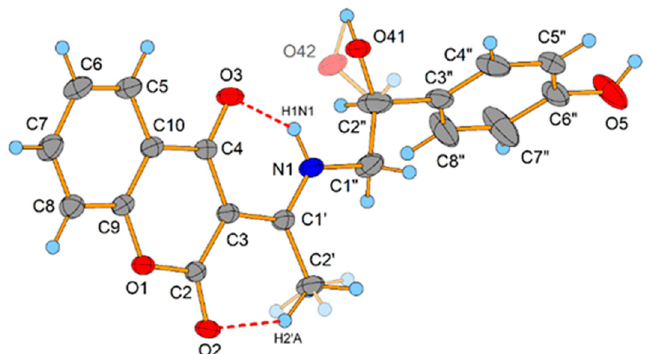
Figure 1. Molecular structure with the atom numbering scheme of L2 . Displacement ellipsoids are drawn at 50% probability; hydrogen bonds are shown as red dashed lines. The disordered parts of hydroxy and methyl groups are shown in lighter colors.